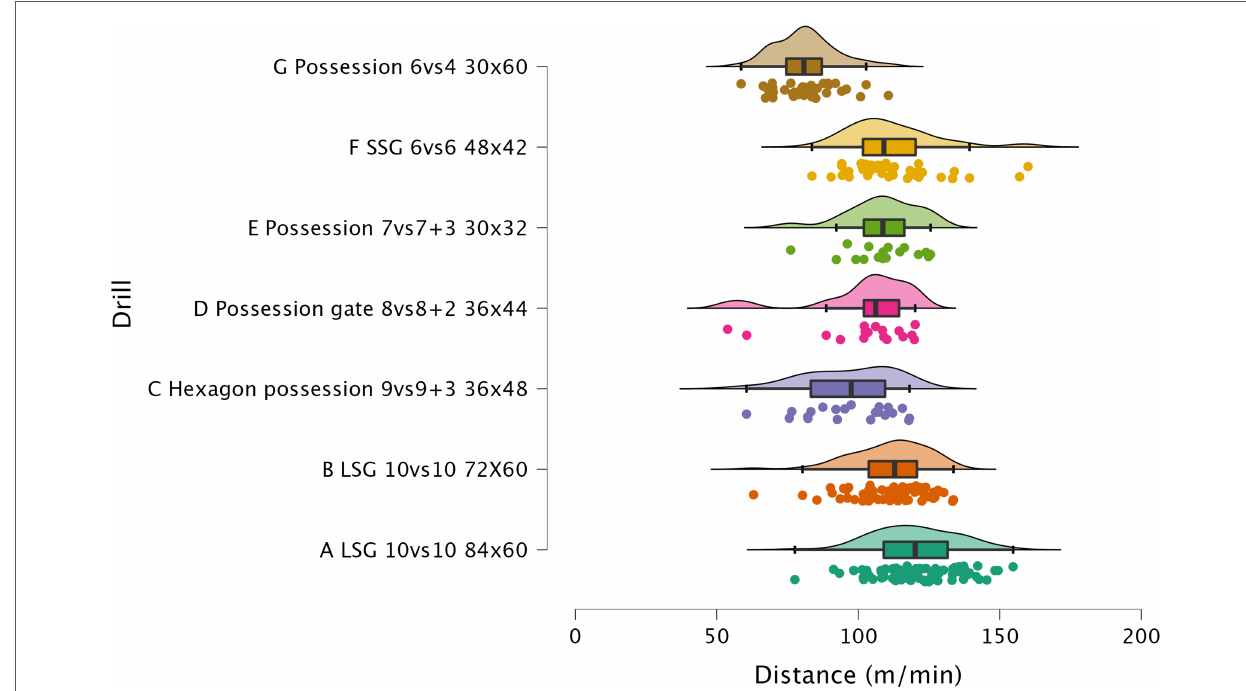
FIGURE 1 Comparison of distance per minute between drills. The data distributions show, mean, standard deviation, 95% con fi dence intervals, and individual data